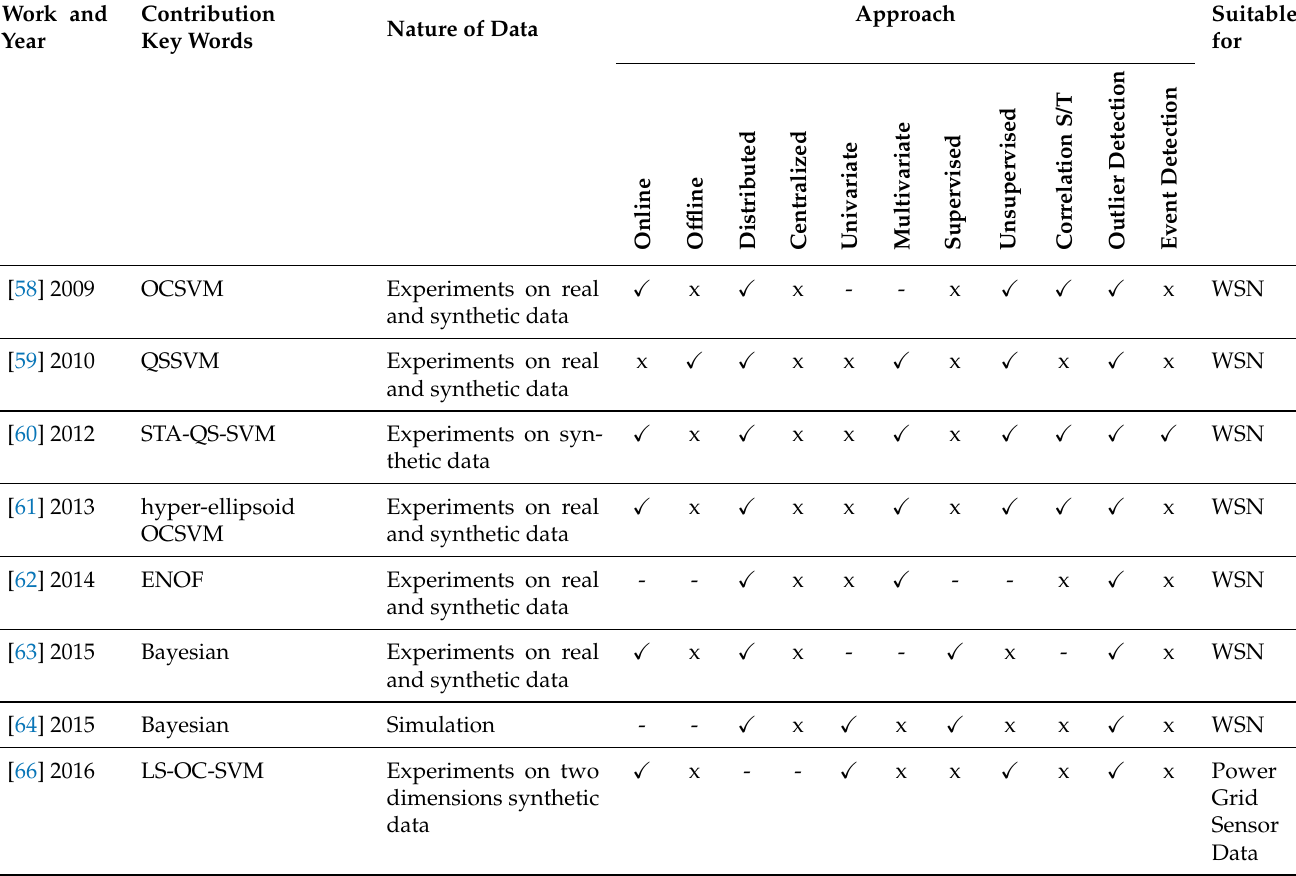
Table 5. Comparative Table of Classification Based